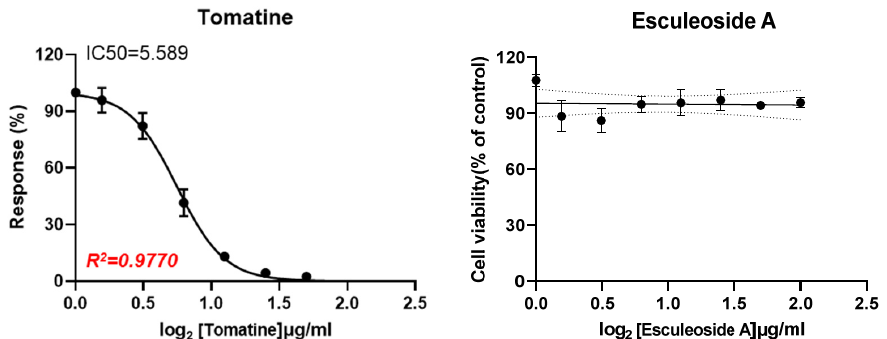
Figure 3. Cytotoxic effects of tomatine and esculeoside A in a dose-dependent manner on the Fadu cell line. Data represent the mean ± SD (n = 3).